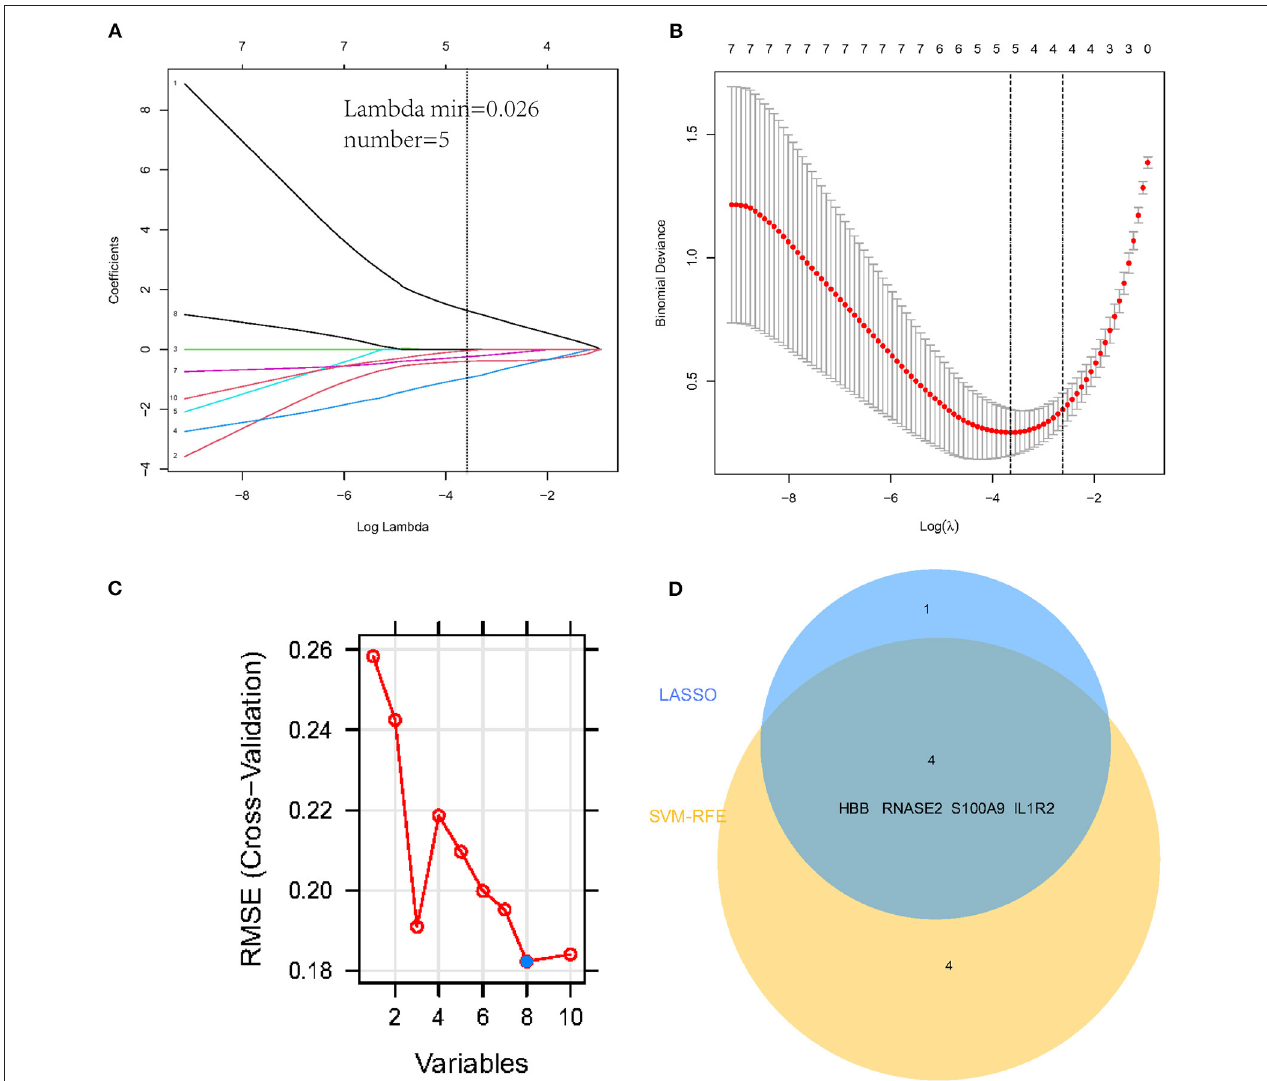
FIGURE 4 | Establishment of prognostic genes signature by LASSO regression analysis and SVM-RFE algorithm. (A) LASSO coefficient profiles of five genes. The dotted vertical line is the value selected using the 10-fold cross-validation in (B) , for which the optimal lambda λ ) resulted in five non-zero coefficients. (B) Identification of the optimal penalization coefficient ( λ ) in the Lasso model used 10-fold cross-validation and the minimum absolute contraction criterion. (C) A plot of feature gene selection by SVM-RFE. The blue dot represents the best eight variables; (D) The Venn plot of overlapped feature genes between LASSO regression analysis and SVM-RFE